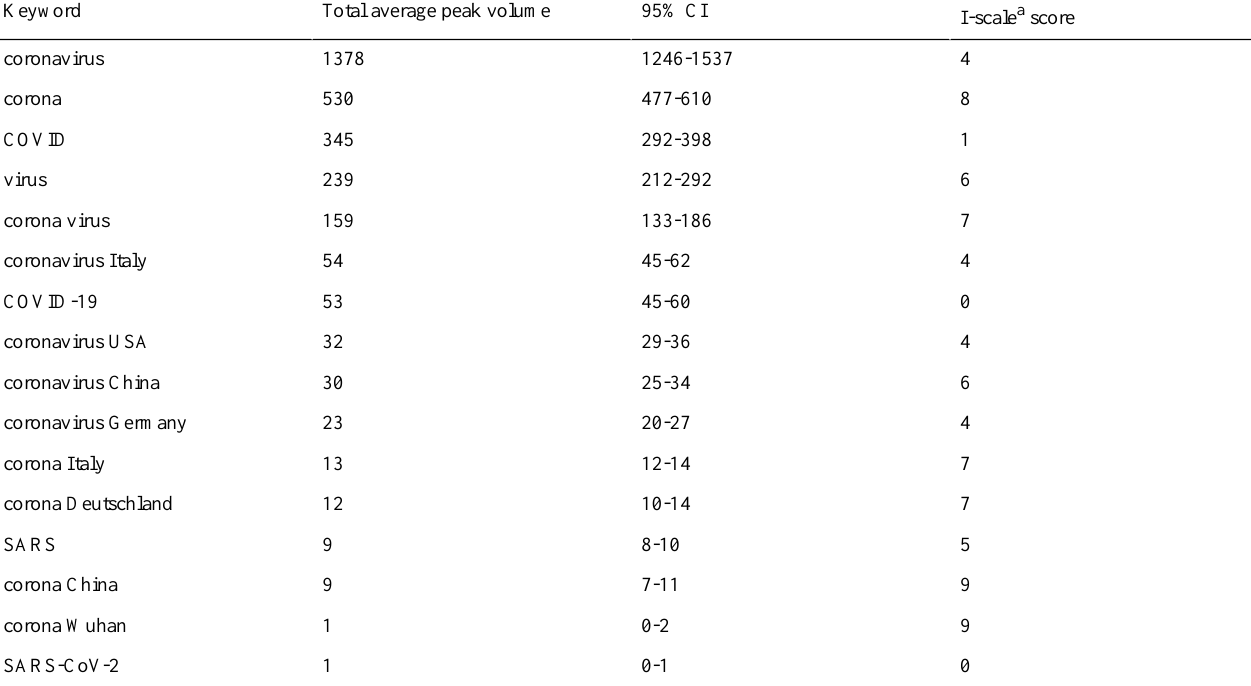
Figure 2. Countries with a higher number of COVID-19